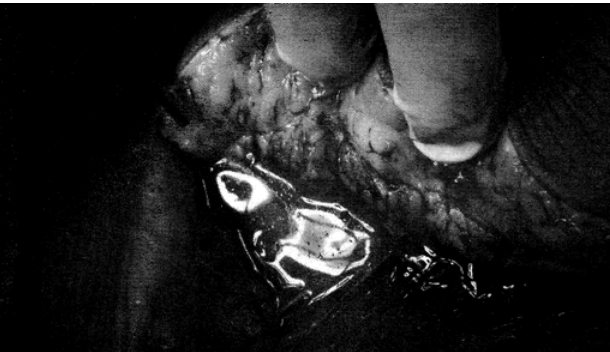
Fig 2: Operative wound showing presence of fat globules in the purulent exudates and evidence of intravascular coagulation noted in the thrombosed veins.